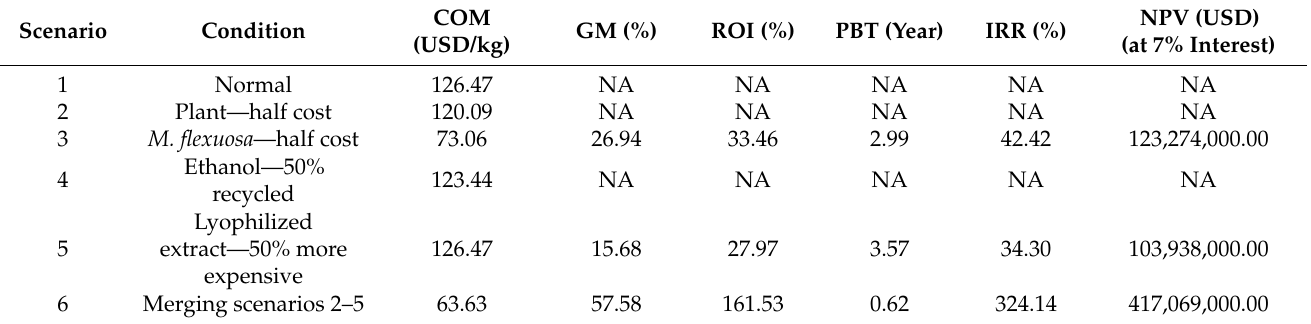
Table 6. Project indices of the single-stage process by conventional solvent extraction (CSE).